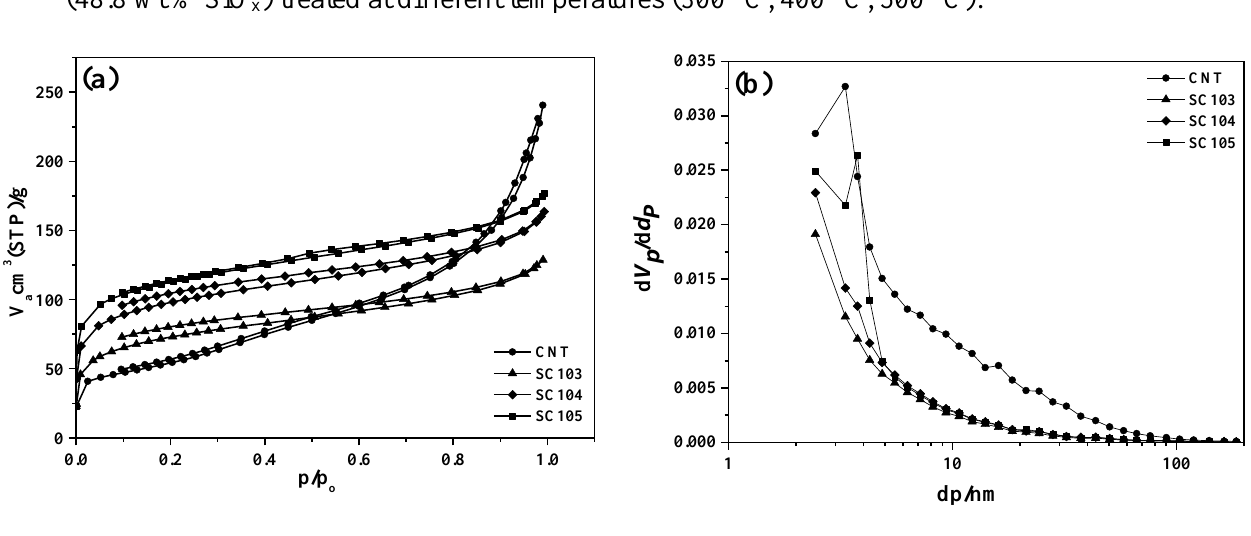
Figure 4. ( a ) Nitrogen isotherm and ( b ) pore size distribution curve of SiO